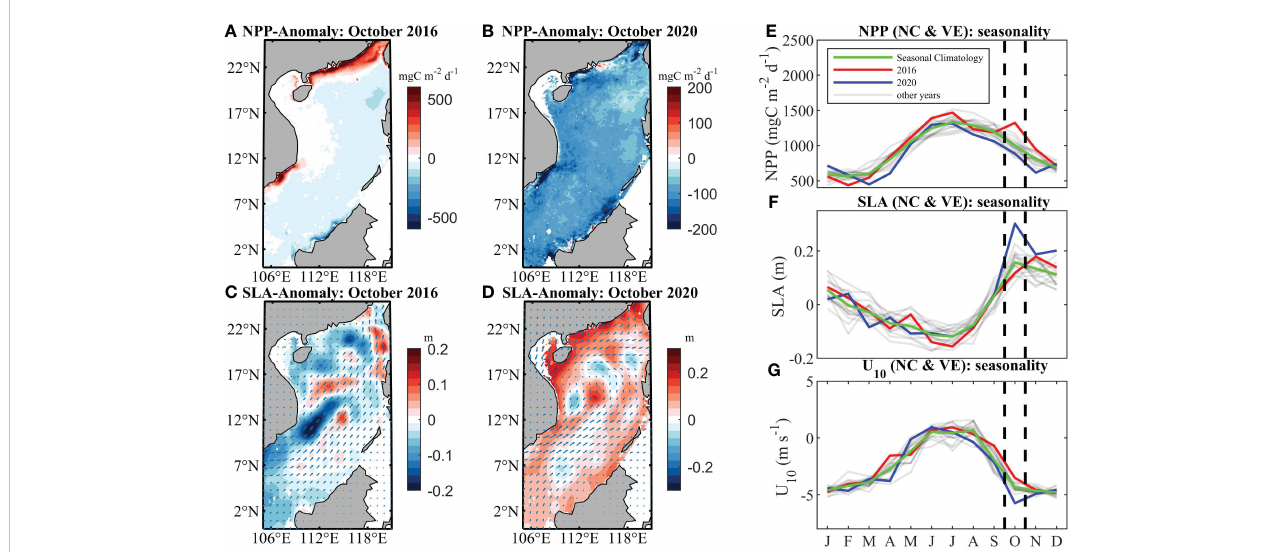
FIGURE 7 Spatial distribution of NPP in the SCS in October from (A) 2016 subtracted from the climatology and (B) 2020 subtracted from the climatology. Spatial distribution of SLA in the SCS in October from (C) 2016 subtracted from the climatology and (D) 2020 subtracted from the climatology. Vectors in (C) and (D) are the anomalous winds in 2016 and 2020. Seasonality of mean (E) NPP, (F) SLA and (G) U 10 in the SCS for the climatology (green), 2016 (red), 2020 (blue) and other years